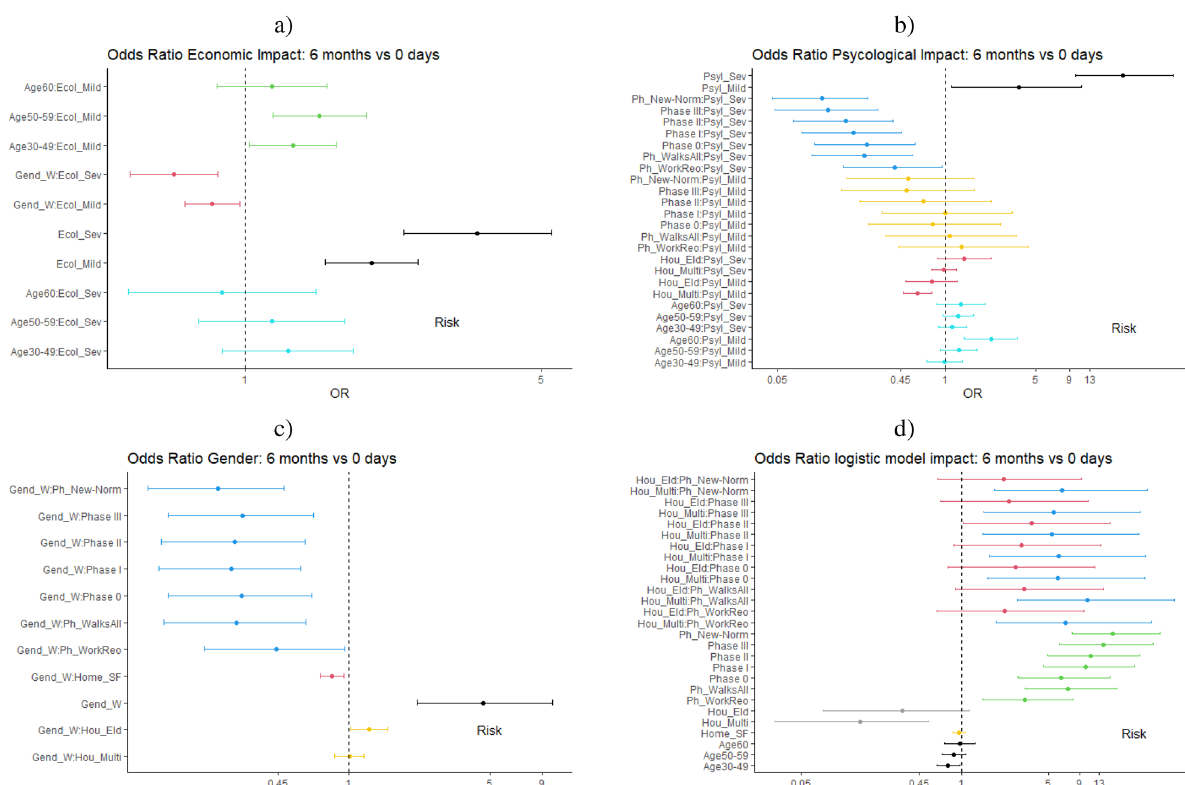
Figure 1. Odds ratios for all the variables with interactions in the logistic regression